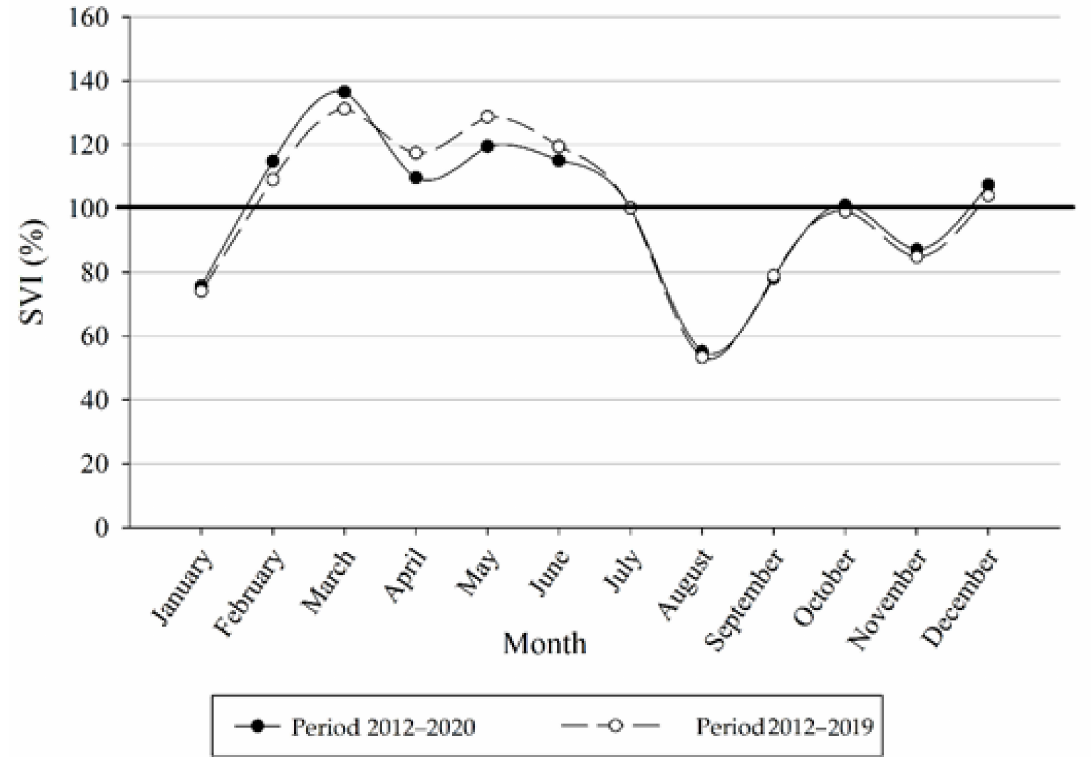
Figure 15. Seasonality pattern of vehicle disembarking traffic of the port of Set ú bal during the periods 2012–2019 and